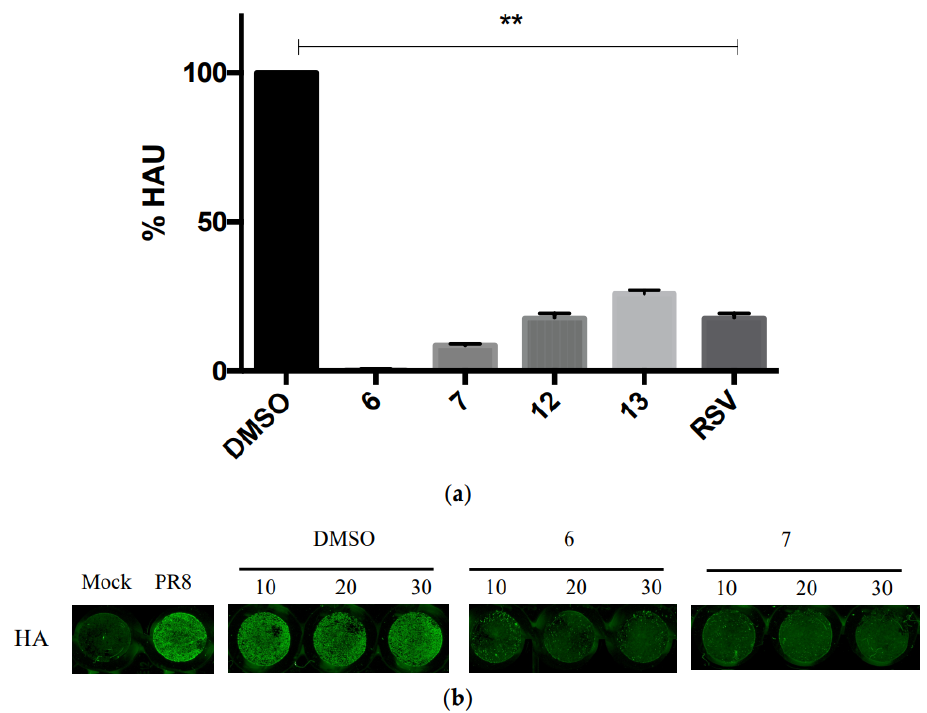
Figure 4. RSV derivatives 6 and 7 impair viral production and reduce viral infectivity. ( a ) Hemag- glutination assay (HAU) on supernatants of A549 cells infected with influenza A PR/8/H1N1 virus and treated with the RSV derivatives (compounds 6 , 7 , 12 , and 13 ), or with RSV at a concentration of 20 µ g/mL. Cells treated with the solvent (DMSO) were used as control. Data are expressed as percentage (%) of HAU and represent the mean ± S.D. of three separate experiments, each performed in duplicate ( n = 6) (** p < 0.001 vs. DMSO treated condition). ( b ) ICW assay of hemagglutinin (HA) protein expression on MDCK cells infected with supernatants obtained from A549 cells treated with different concentrations (range: 10–30 µ g/mL) of RSV derivatives. Images represent one experiment of two